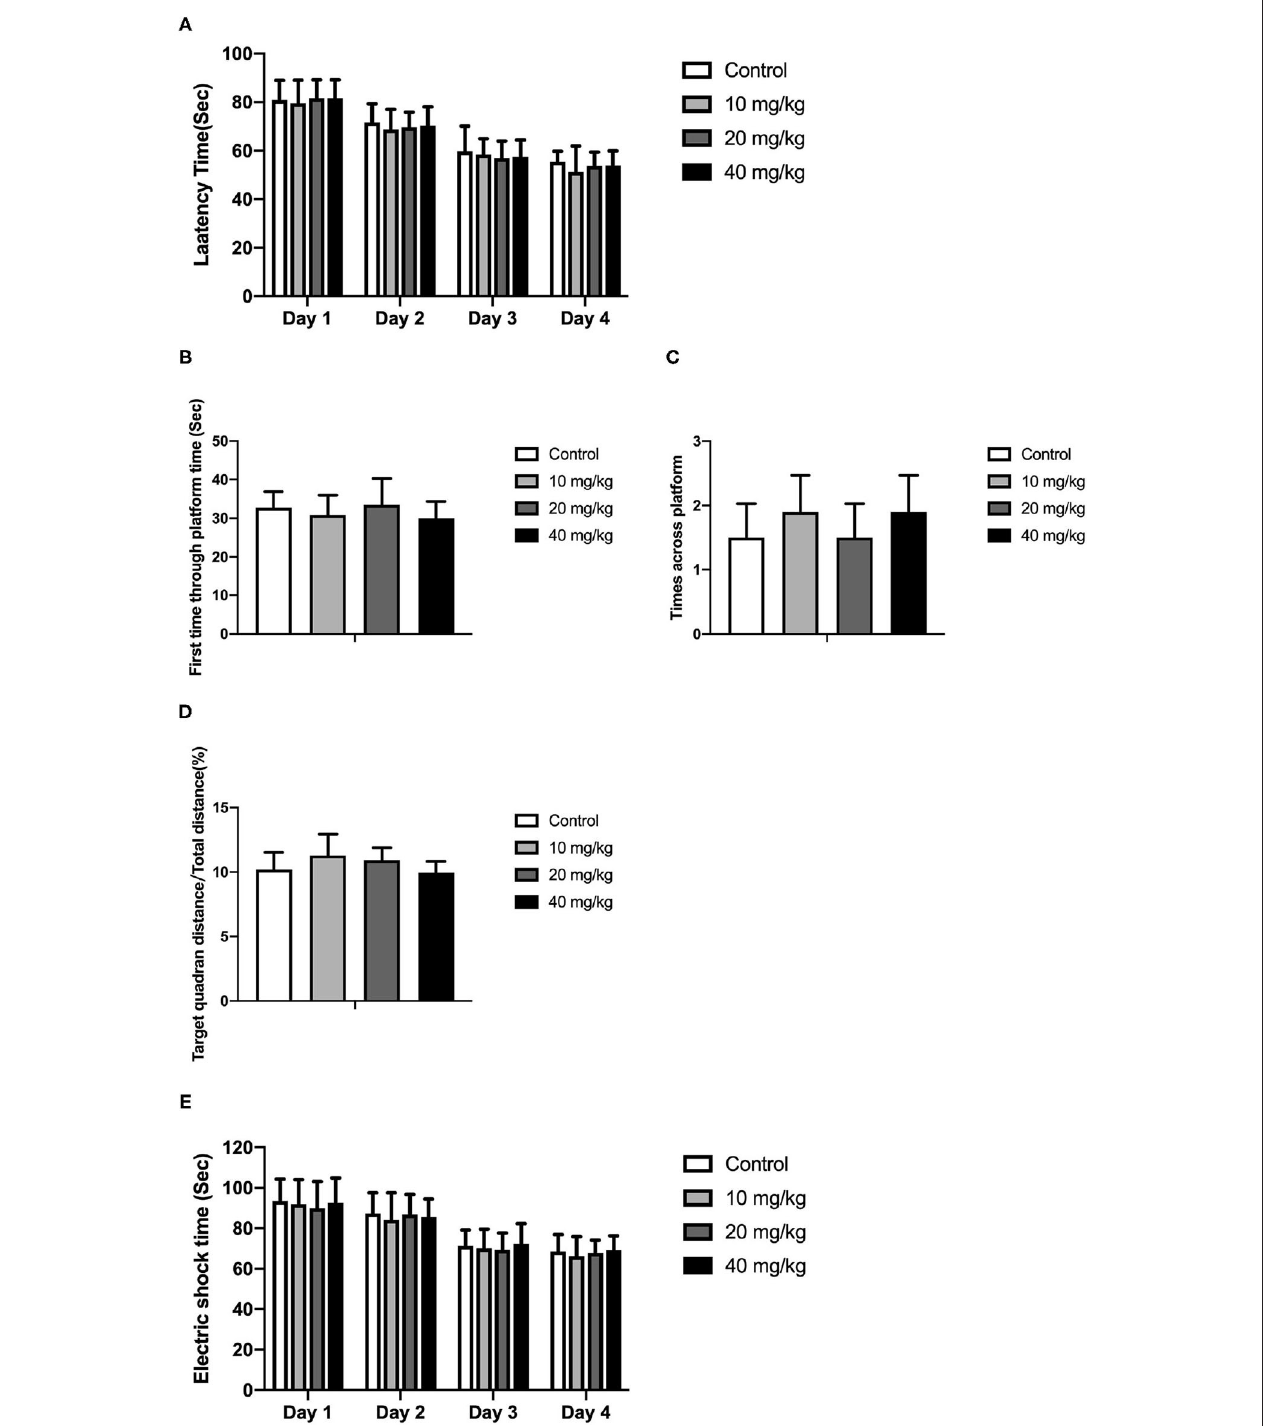
FIGURE 6 | Effects of Neu5Ac exposure on the Morris water maze test and shuttle box test in 100-day-old male rats. These rats were treated with Neu5Ac [10, 20, or 40 mg/(kg · day)] or as control from the 21st day of age to the 45th day of age. (A) The latency to find the platform in the Morris water maze test; (B) the first-time-through-platform time, (C) the across-platform number; and (D) the effective swim distance in the probe test. (E) Electric shock time in the shuttle box test. The shuttle box test was used to evaluate avoidance learning and memory ability in mice following the Morris water maze (MWM) test. The results are expressed as the M ± SD ; n = 10 per